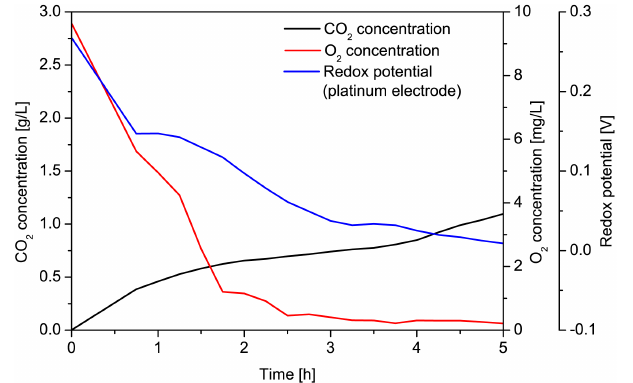
Figure 8. Course of the carbon dioxide and oxygen concentration as well as the redox potential in the start phase of a yeast fermenta- tion in a laboratory reactor (volume: 150L; 294K).